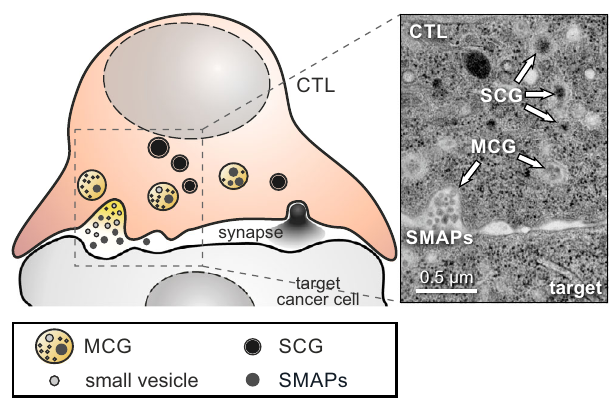
Fig. 8 MCG as a distinct class of cytotoxic granules for SMAP release. Proposed model of a cytotoxic T lymphocytes that contains two classes of CGs (MCG and SCG), both of which can fuse in parallel at the immunological synapse (left). While the SCG content diffuses rapidly after release, MCGs deposit supramolecular attack particles (SMAPs) that retain their integrity in the synaptic cleft. The latter is illustrated in the exemplary electron micrograph on the pMAX vector 25 . The antibodies used in this work are described in detail in Table 1. All the antibodies except anti-Sec61 β antibody are commercially available and are well-established and shown to be valid. The validation of the in-house generated antibody anti-Sec61 β antibody is shown in the Source Data fi le (Supplementary Fig. 2a). Flow cytometry . For fl ow cytometry analysis, 0.2 – 0.5× 10 6 CD8 + T cells were resuspended in D-PBS (Gibco) and incubated in the dark for 30min on ice with cell surface speci fi c FITC-, APC or PE-conjugated antibodies against CD44, CD62L and CD25 (Table 1). The viable T lymphocytes was gated based on their size and granularity. Effector Syb2 KI cells were gated using the mRFP signal compared to the baseline signal of wild type cells. The fl uorescence signal of antibody stained cells were further analyzed by subtracting mRFP signal in unstained Syb2 KI cells. Finally, the immune cell subsets were analyzed according to the antibody labeling. Data were acquired by using a BD FACSAria III analyzer (BD Biosciences) with BD FACSDiva software 6.0. The data were analyzed with FlowJo v10.0.7 software. Cell homogenization and subcellular fractionation . 0.8-1.2 ×10 8 activated CD8 + T cells from one Syb2 KI mouse, 0.7 – 0.8 ×10 8 unstimulated naive CD8 + T cells from four to six Syb2 KI mice or 0.8× 10 8 activated CD8 + T cells from one Syb2 KI/GzmB DKI mouse were harvested and washed once in buffer (Invitrogen, PBS with 0.1% BSA and 2mM EDTA) before resuspension in 2 ml of homogenization buffer (300 mM sucrose, 10 mM HEPES (pH 7.3), 5mM EDTA (pH 8.0) supple- mented with protease inhibitors (3 mM Pefabloc, 10 µM E64 and 10 µg Pepstatin A). The cell suspension was transferred into a pre-chilled cell disruption bomb (Parr 1019HC T304 SS) connected to a nitrogen source. After 25 min equilibration at 800 psi the nitrogen pressure was released and the cell homogenate was collected. The cell lysate was centrifuged for 10 min at 1000 × g at 4 °C to pellet unbroken